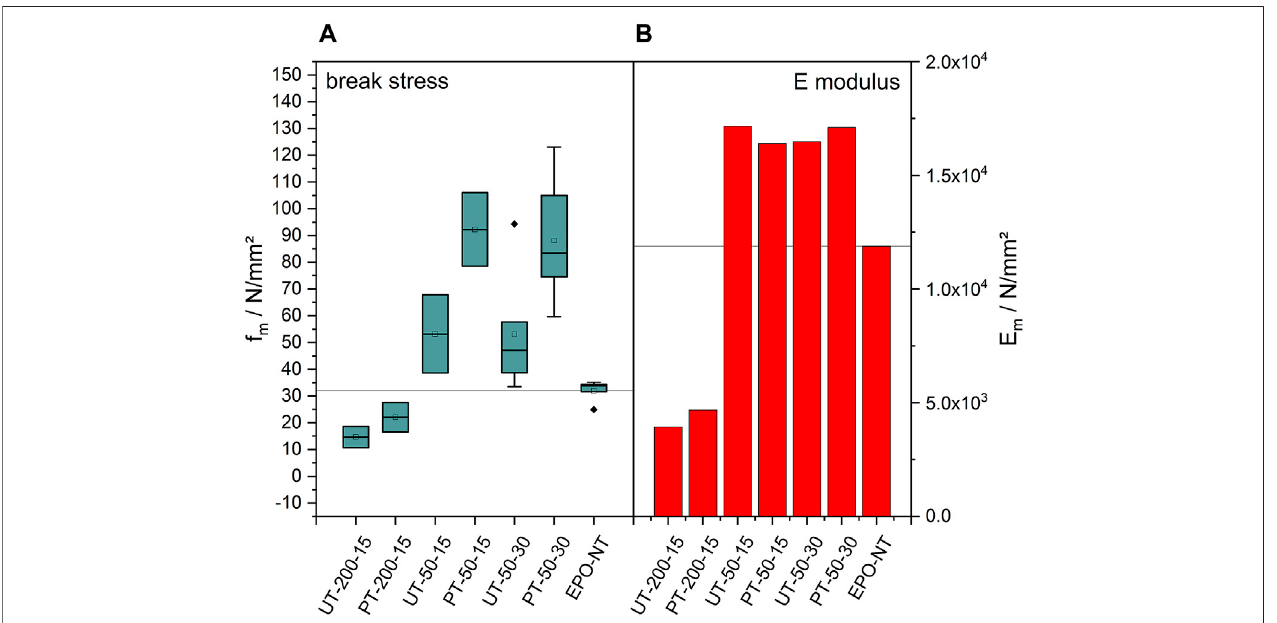
FIGURE 4 | Maximum break stress (A) and determined E modulus (B) from bending strength testing for spruce-aluminum composites with PVAc adhesive with plasma(PT)andwithoutpretreatment(UT)curedinahydraulicpressat8barfor15 min(200 – 15),2 barfor15 min(50 – 15)andat2 bar for30 min(50 – 30), aswellasfor reference specimens prepared without plasma and press using epoxy